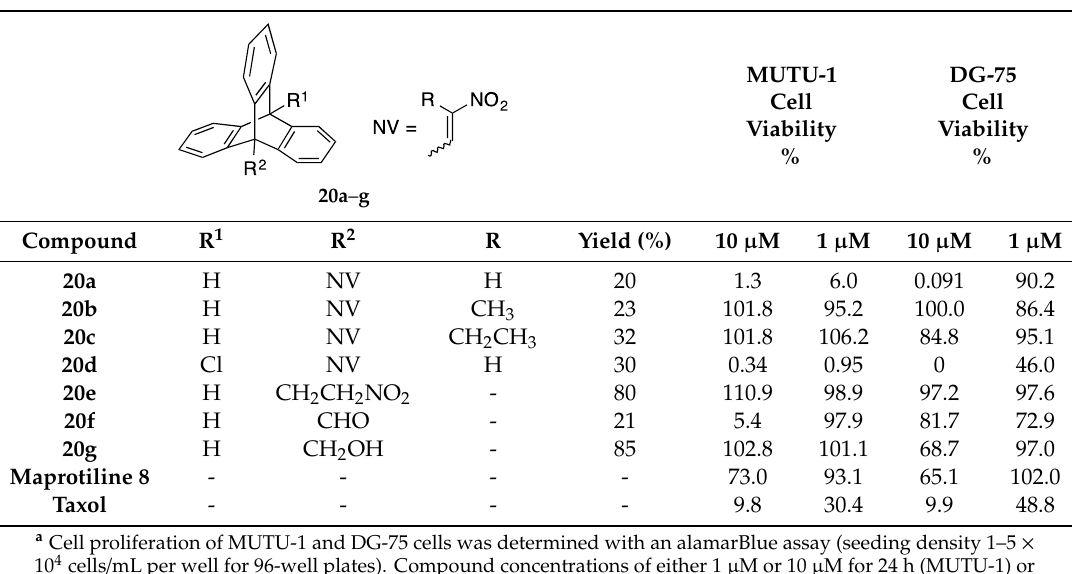
Table 7. Yields and preliminary cell viability data for compounds 20a – g (Series V) in MUTU-1 and DG-75 Burkitt lymphoma cell lines a .